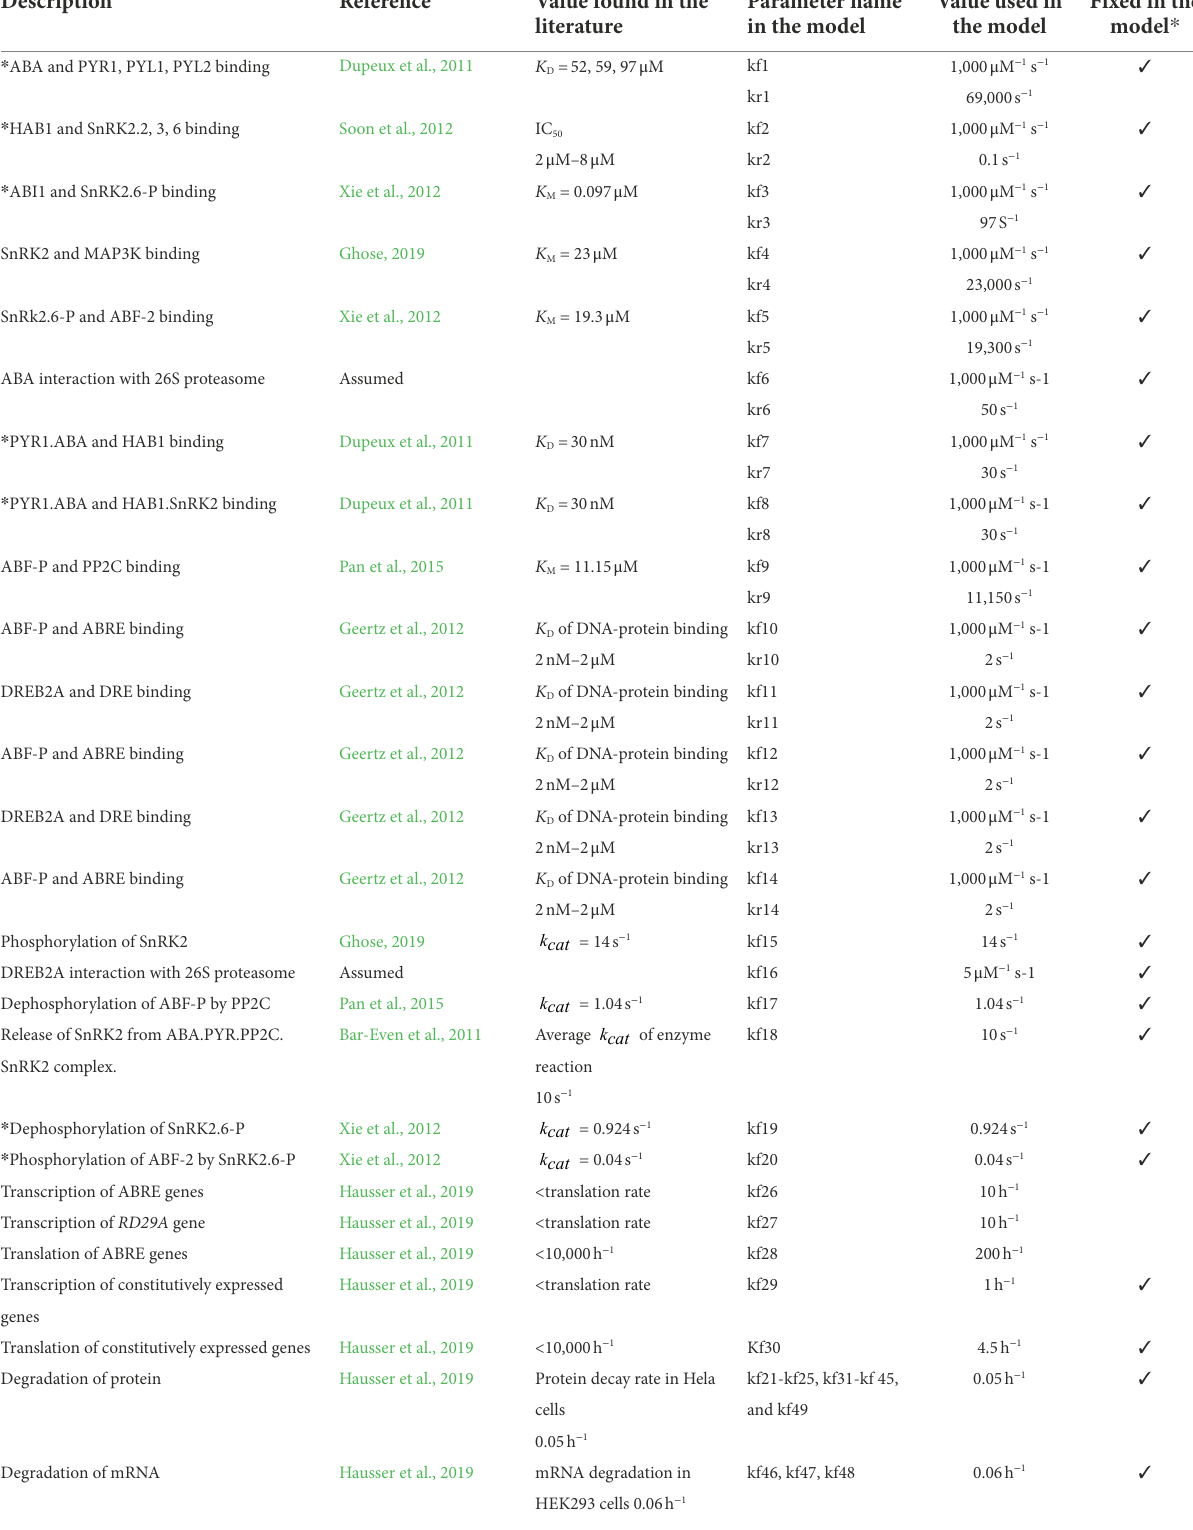
TABLE 1 Curated values from literature and the values chosen as parameters for the model.